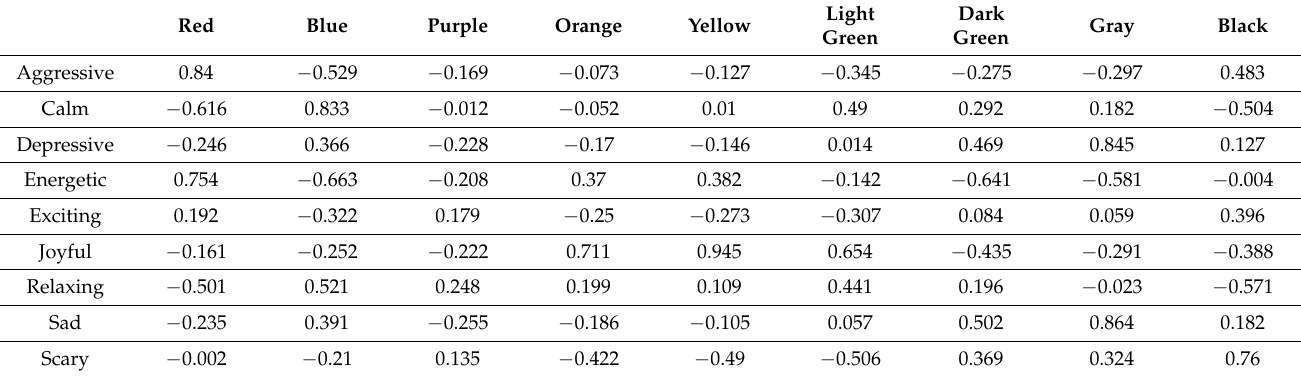
Table 7. Pearson’s correlation coefficient r for emotions from the proposed model and color